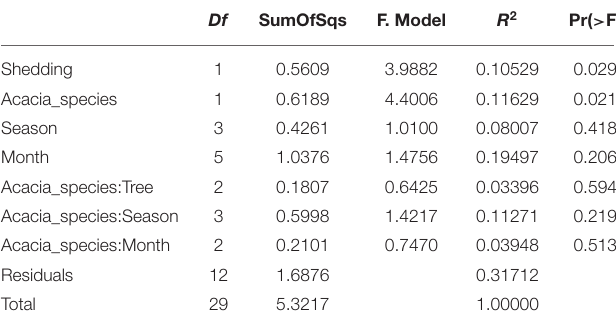
TABLE 3 | PERMANOVA analysis showing statistical significance of epiphytic and endophytic microbial communities across sampling months.